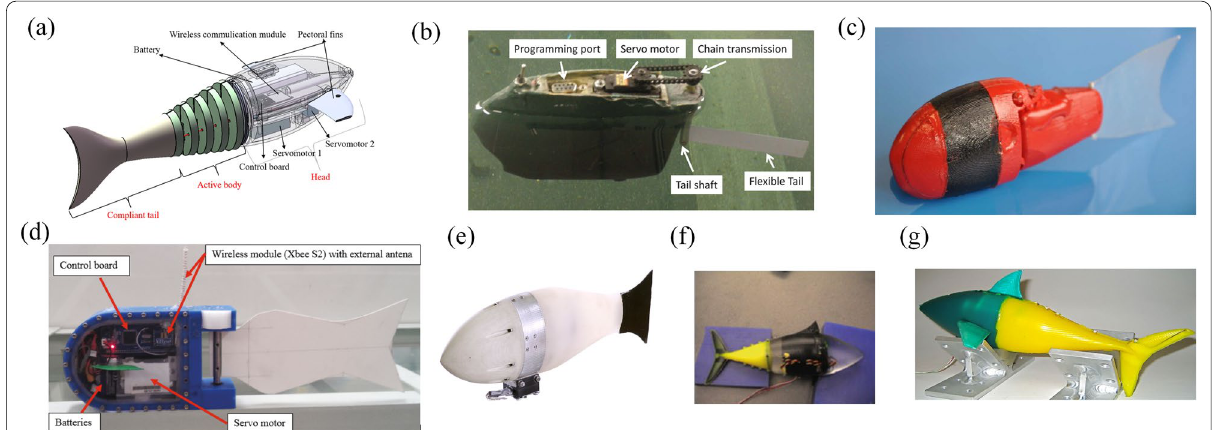
Table 5 A summary of soft actuations used in robotic fish